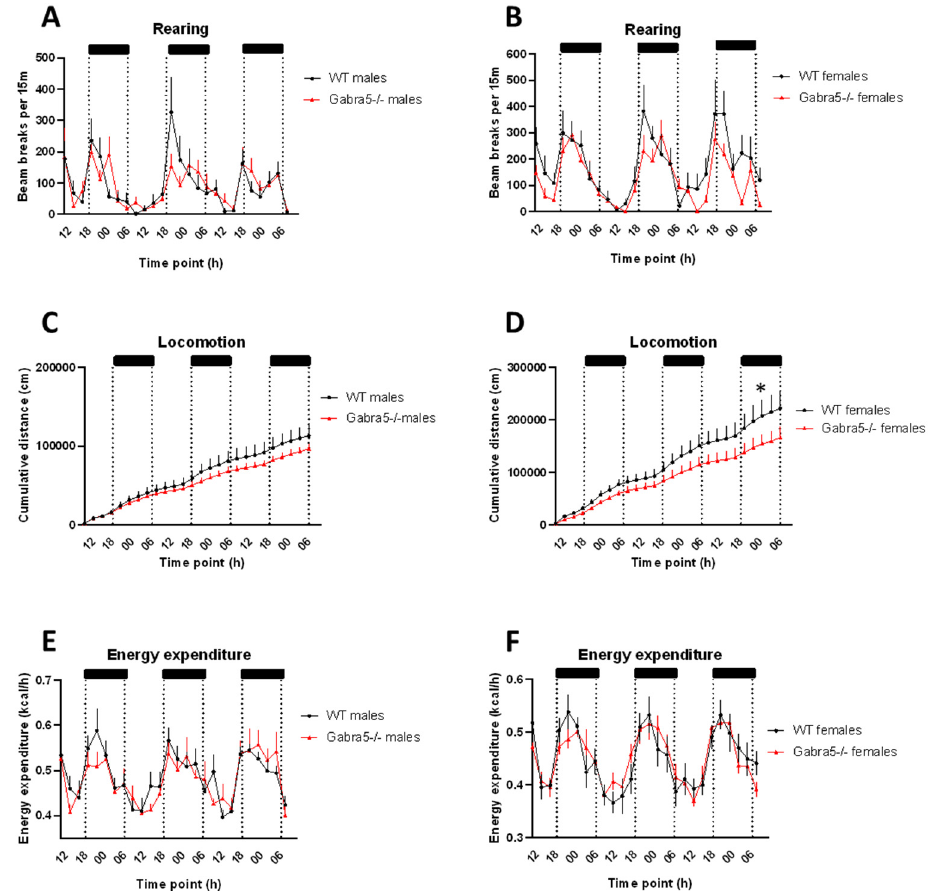
Figure 5. Indirect calorimetry- Rearing, locomotion, and energy expenditure. ( A , B ) rearing was decreased during the dark phases (shaded) in KO animals. ( C , D ) a tendency of decreased locomotion was observed in Gabra5 − / − animals of both sexes however significant for females. ( E , F ) Energy expenditure was not significantly altered for either sex. Regression analysis, n = 8. All figures depict mean ± SEM. Significant effects of genotype is indicated as * p <